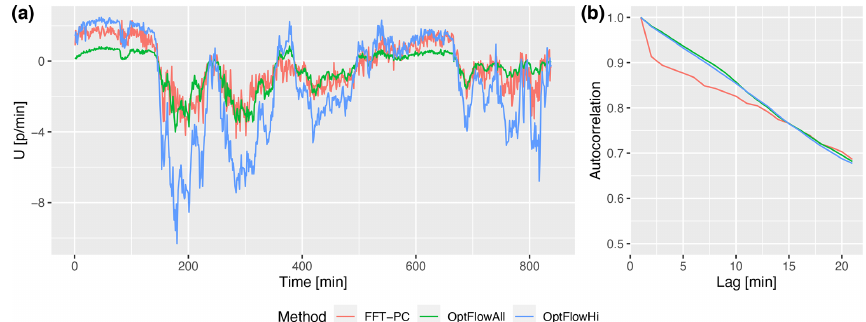
Figure 12. Comparison of mean cloud motion estimated using PC and OF methods on 26 July 2016 over Lamont, OK. The mean OF vectors computed with all valid data and after removing low values are shown with green (OptFlowAll) and blue (OptFlowHi) lines, respectively. (a) Time series of domain average U component taken at the central 400 × 400 pixel region at a 1min interval. No smoothing is applied to this plot. (b) Lag autocorrelation function shows the stability of the vectors.